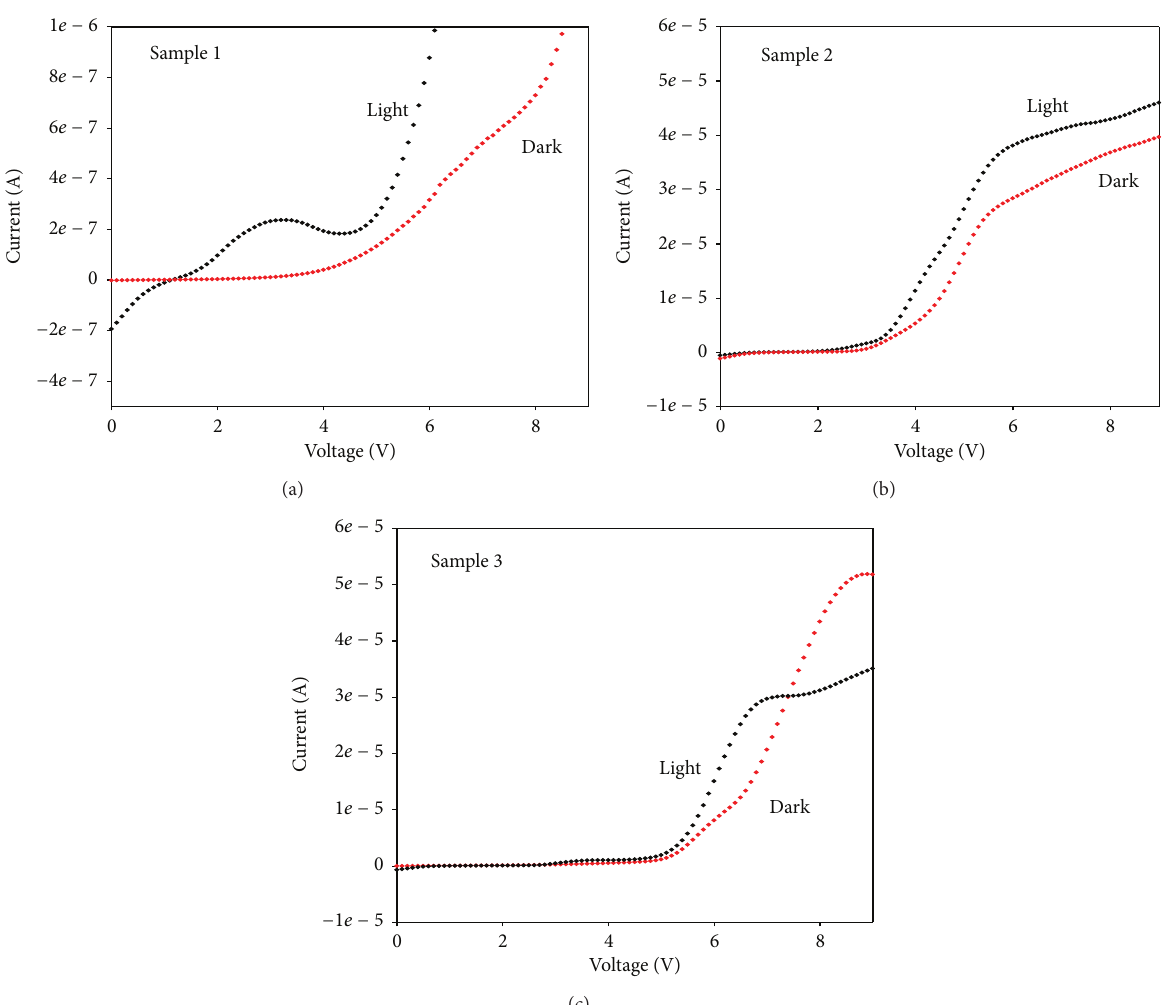
annealed at 350 ∘ C in 5% H 2 + 95% N 2 atmosphere.